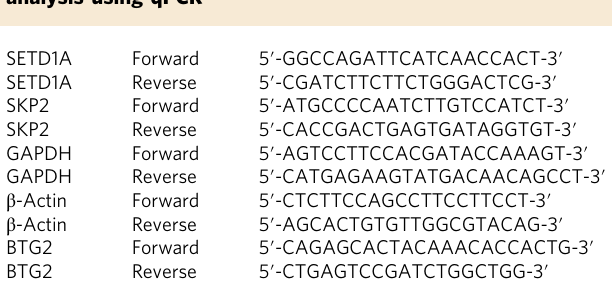
qPCR . RNA was isolated using RNeasy Mini kit (Qiagen) and mRNA quantitation was performed using SYBR Green in an ABI PRISM 7500 sequence detection system with 96-block module and automation accessory (Applied Bio-system). GAPDH or ß-actin was used as an internal control. All samples were analyzed in triplicate. The primer sequences are listed in the Table 2.